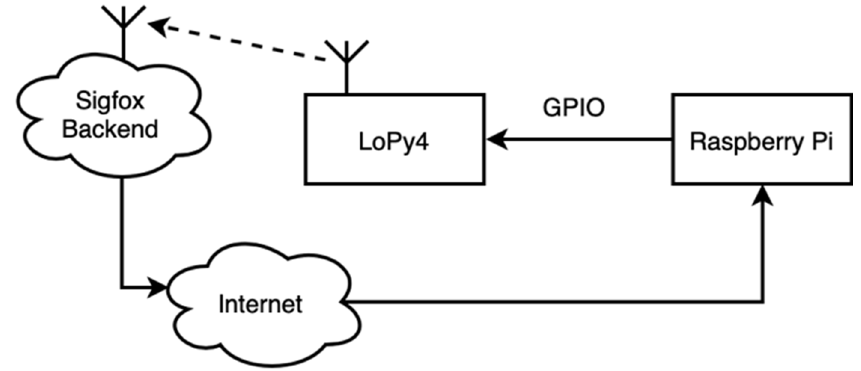
Figure 13. Conceptual diagram of the test-bench deployed for metering Sigfox latency.